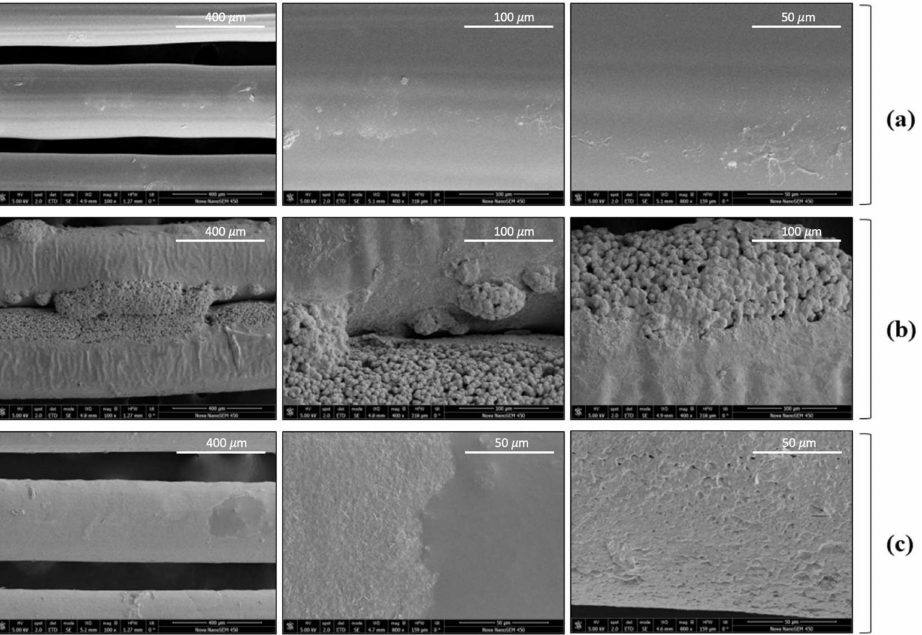
Figure 9. Scanning electron microscopy examination of 3D + SCI samples: ( a ) PLA control disks (100 × , 400 × , 800 × ); ( b ) 35 ◦ C, 100 bar (100 × , 400 × , 400 × ); and ( c ) 35 ◦ C, 400 bar (100 × , 800 × , 800 ×